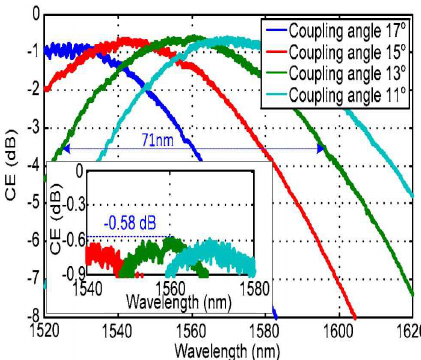
Figure 8. Highly efficient grating with an aluminium bottom reflector with a coupling efficiency of -0.58 (Image reprinted with permission from [25]). Table 1. Summary of various Silicon-on-Insulator (SOI) based fiber to chip grating couplers that include uniform as well as non-uniform (apodized) designs. Full etch signifies SWG couplers. CE refers to the coupling